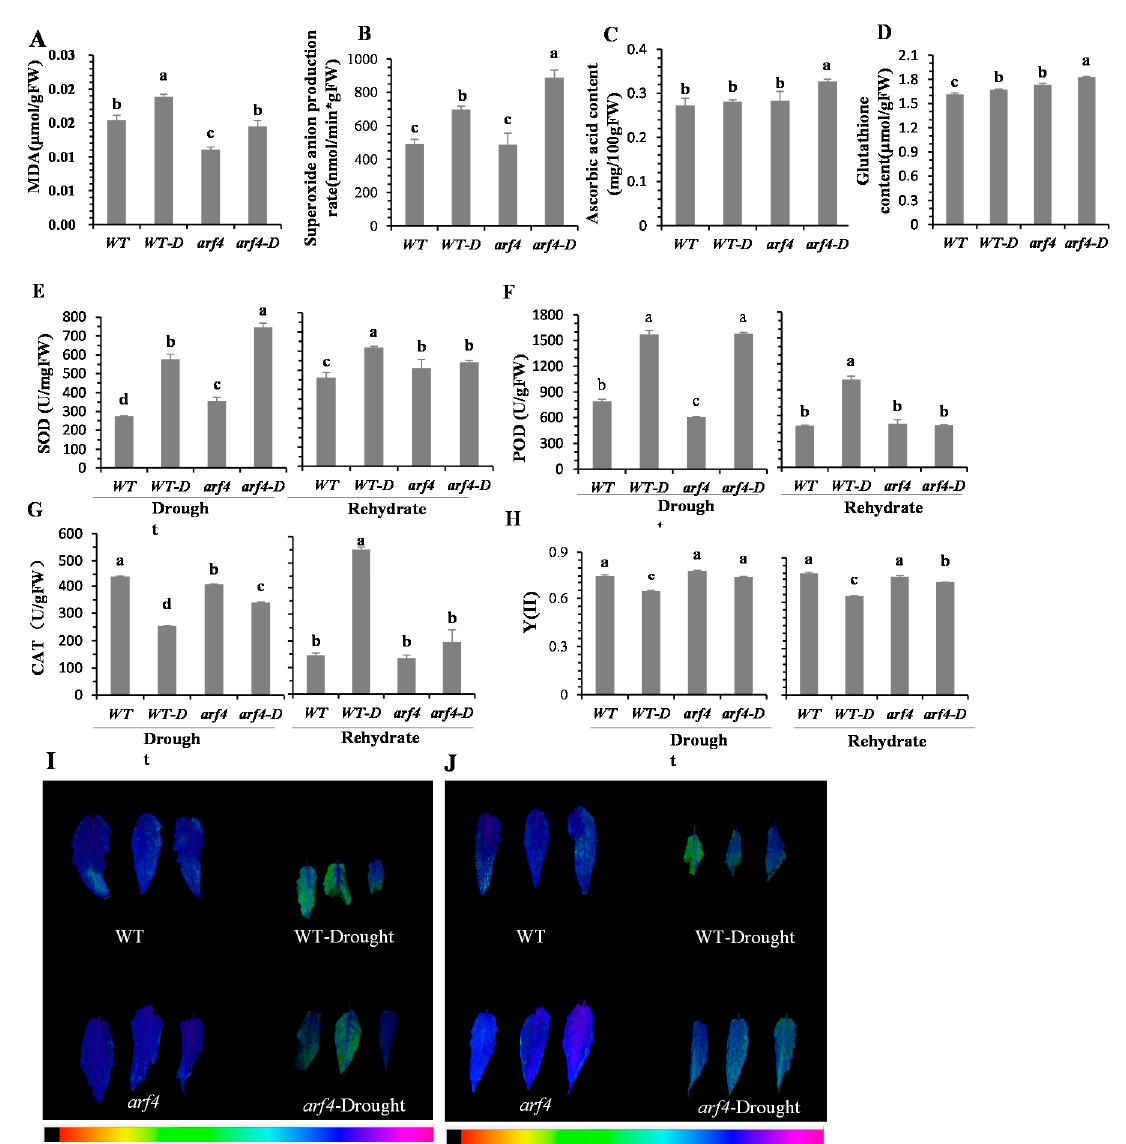
Figure 4. Effect of water stress on antioxidant capacity of WT and arf4 mutant tomato leaves. ( A ) malondialdehyde (MDA) content; ( B ) superoxide anion production rate; ( C ) ascorbic acid content; ( D ) glutathione content; ( E ) superoxide dismutase (SOD) activity of plant under 12 days water deficit and 1 day of re-watering; ( F ) peroxidase (POD) activity of plant under 12 days water deficit and 1 day of re-watering; ( G ) catalase (CAT) activity of plant under 12 days water deficit and 1 day of re-watering; ( H ) the actual photochemical efficiency of PSII (YII) of plant under 12 days water deficit and 1 day re-watering. ( I ) The maximum photochemical efficiency of PSII (Fv/Fm) was determined on well watering plant and plant with 12 days water deficit. The underneath color code depicted in the image ranges from 0 (black) to 1 (purple); ( J ) The maximum photochemical efficiency of PSII (Fv/Fm) was determined on well watering plant and plant after one day of re-watering. The underneath color code depicted in the image ranges from 0 (black) to 1 (purple). Different letters (a, b, c, d) present significant difference at level set p < 0.05. WT-D and arf4-D represent wild-type (WT) and arf4 under water deficit, respectively.